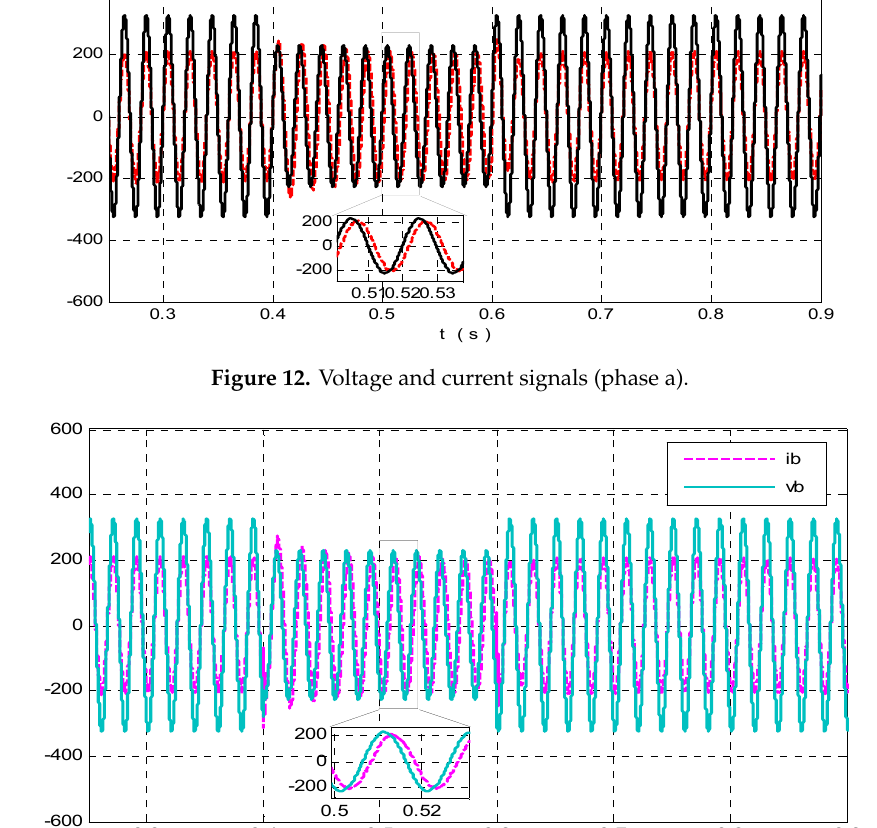
Figure 13. Voltage and current signals (phase b).